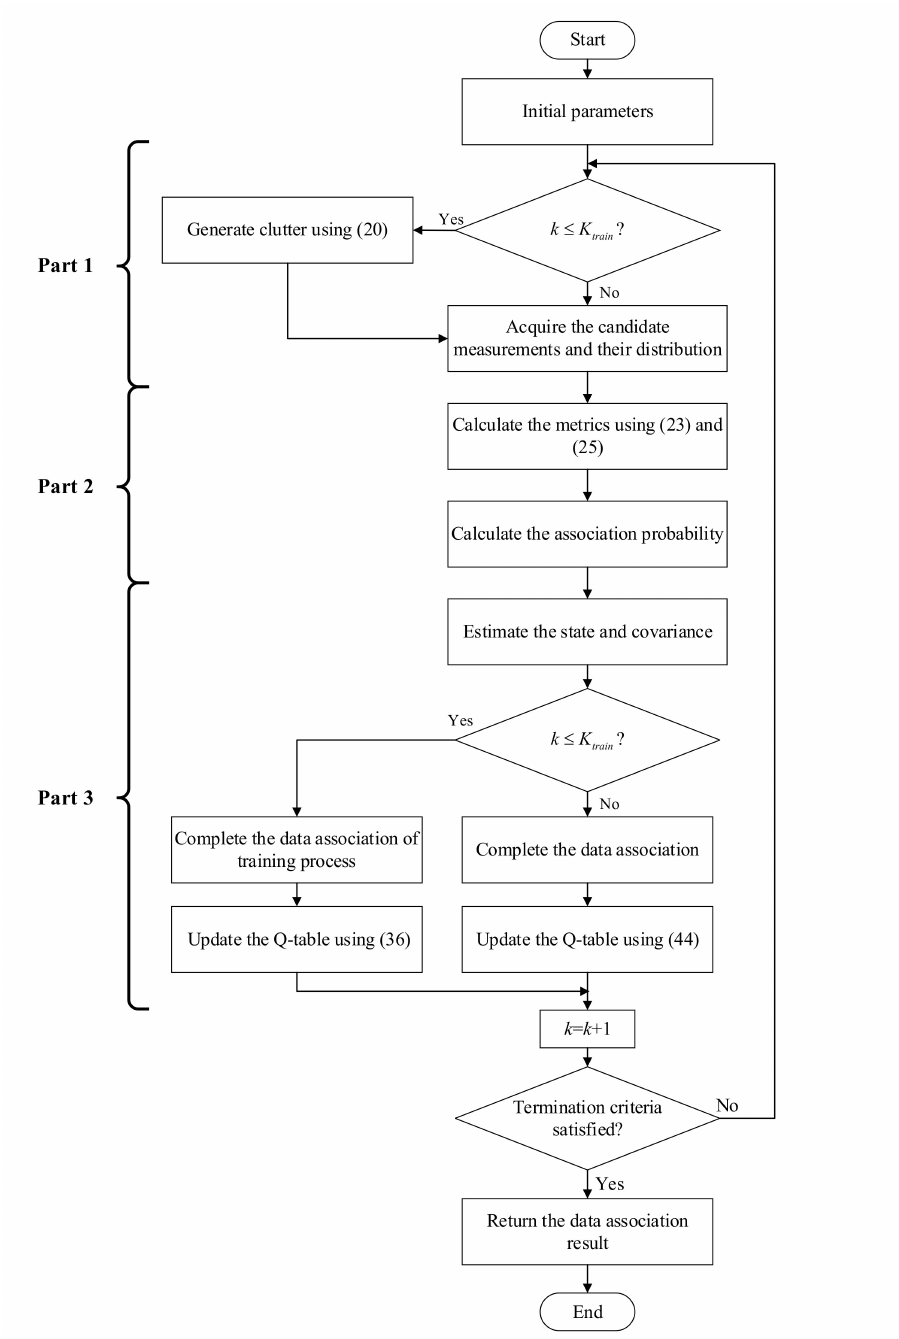
Figure 1. The flow chart of the reinforcement learning-joint probabilistic data association (RL-JPDA)